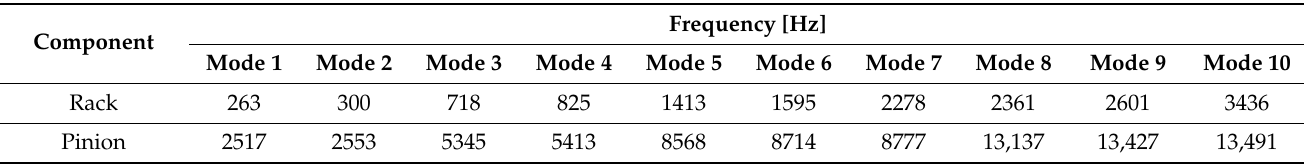
Figure 3. Experimental modal analysis: rack points and mode shapes. Tables 1 and 2 present the full list of the modes and frequencies of the rack and pinion. Table 1. Numerical modal modes.